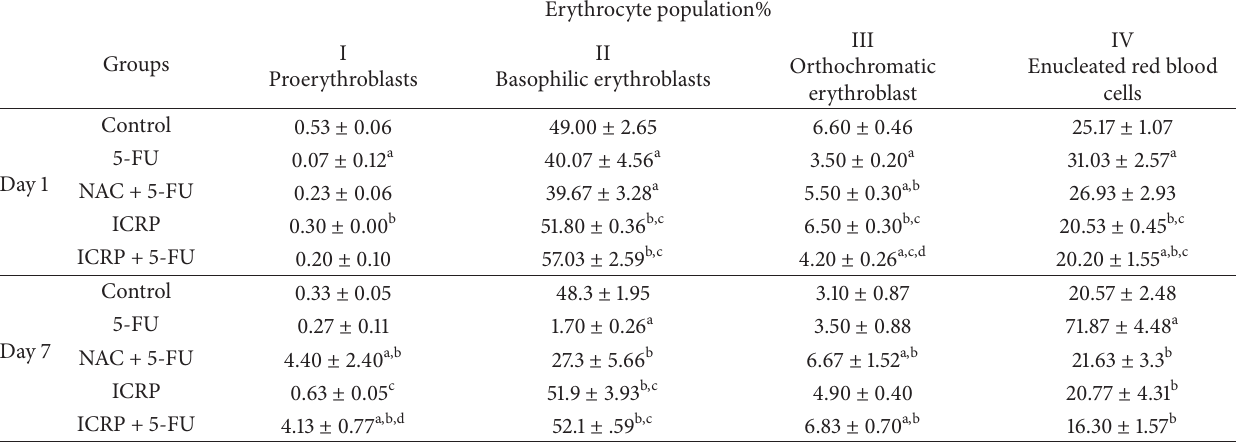
Table 2: Effects of 5-FU, NAC + 5-FU, ICRP, and ICRP + 5-FU on erythrocyte population in treated mice.